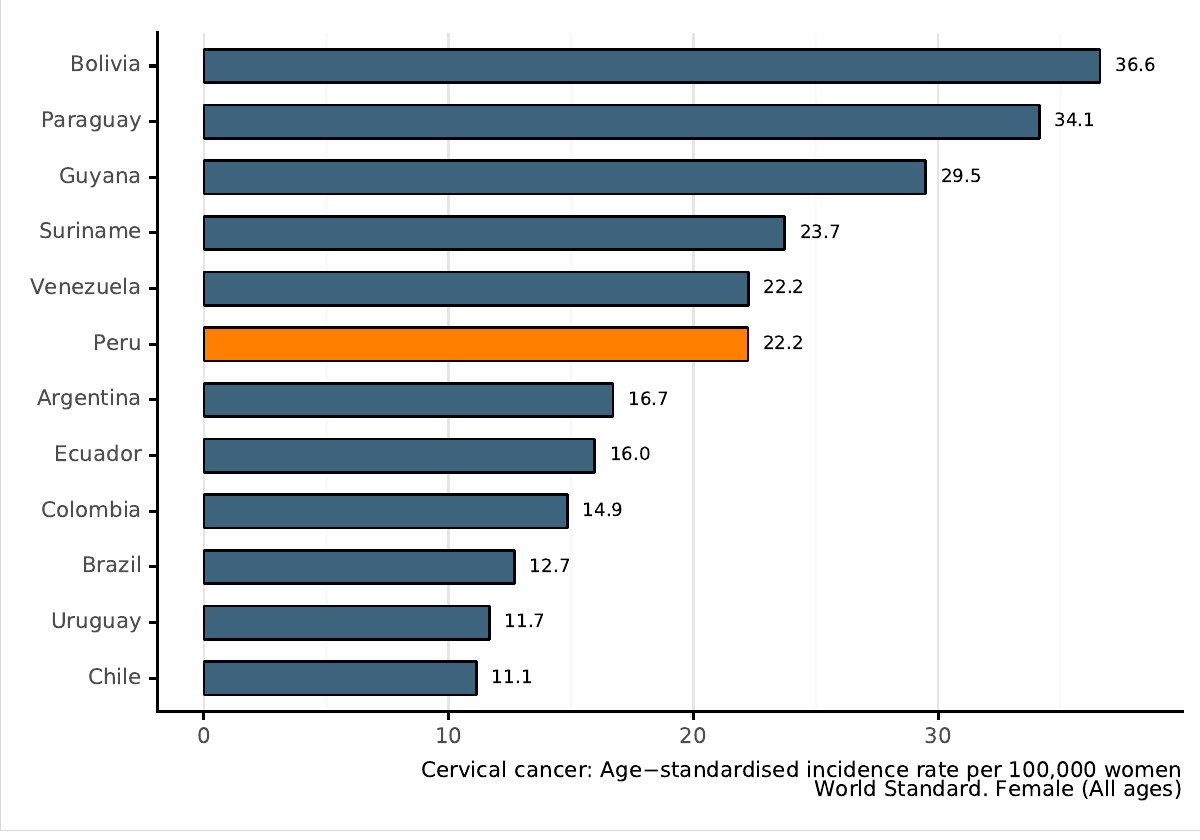
Figure 73: Age-standardised incidence rates of cervical cancer of Peru (estimates for 2020)